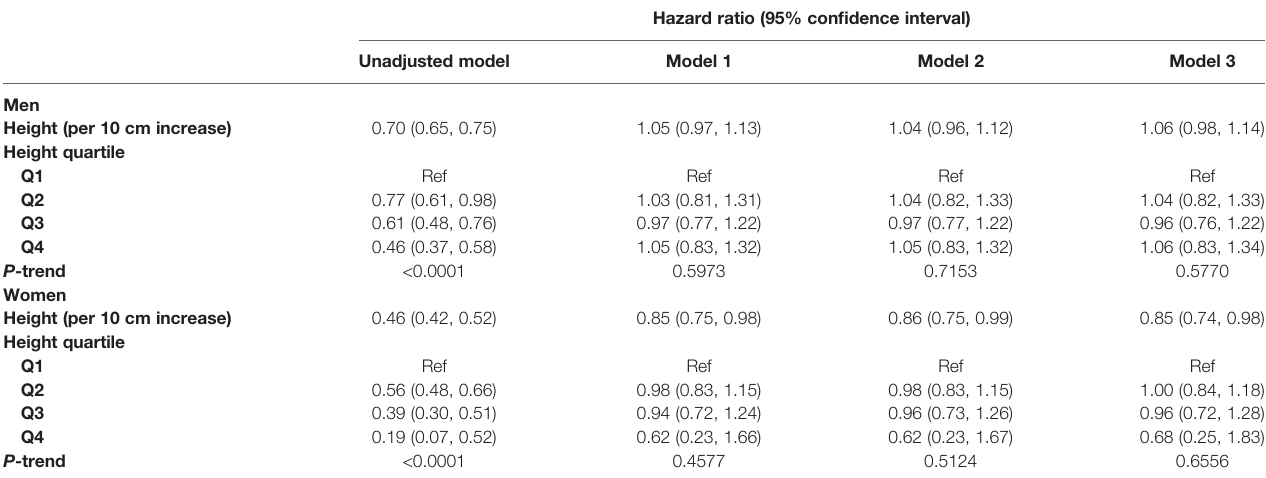
TABLE 3 | Cox regression analyses for the association between height and DM in different models in men and